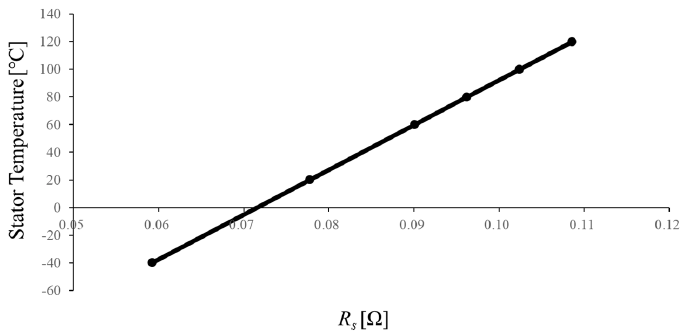
Figure 8. Motor parameter map according to stator winding temperature.